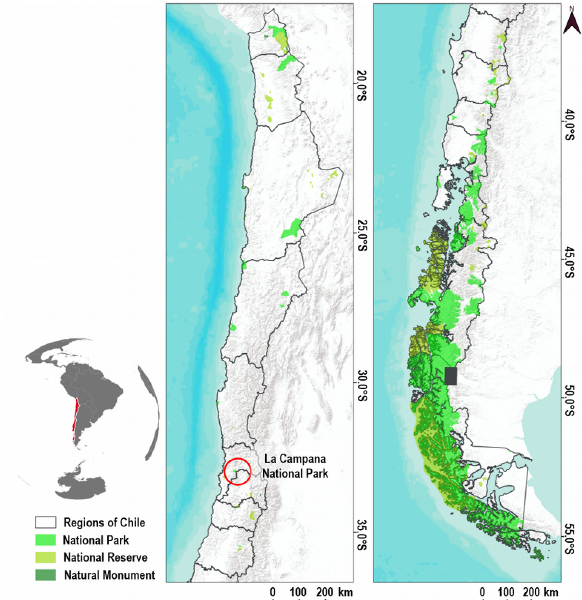
Figure 1 . Chilean network of protected areas SNASPE.